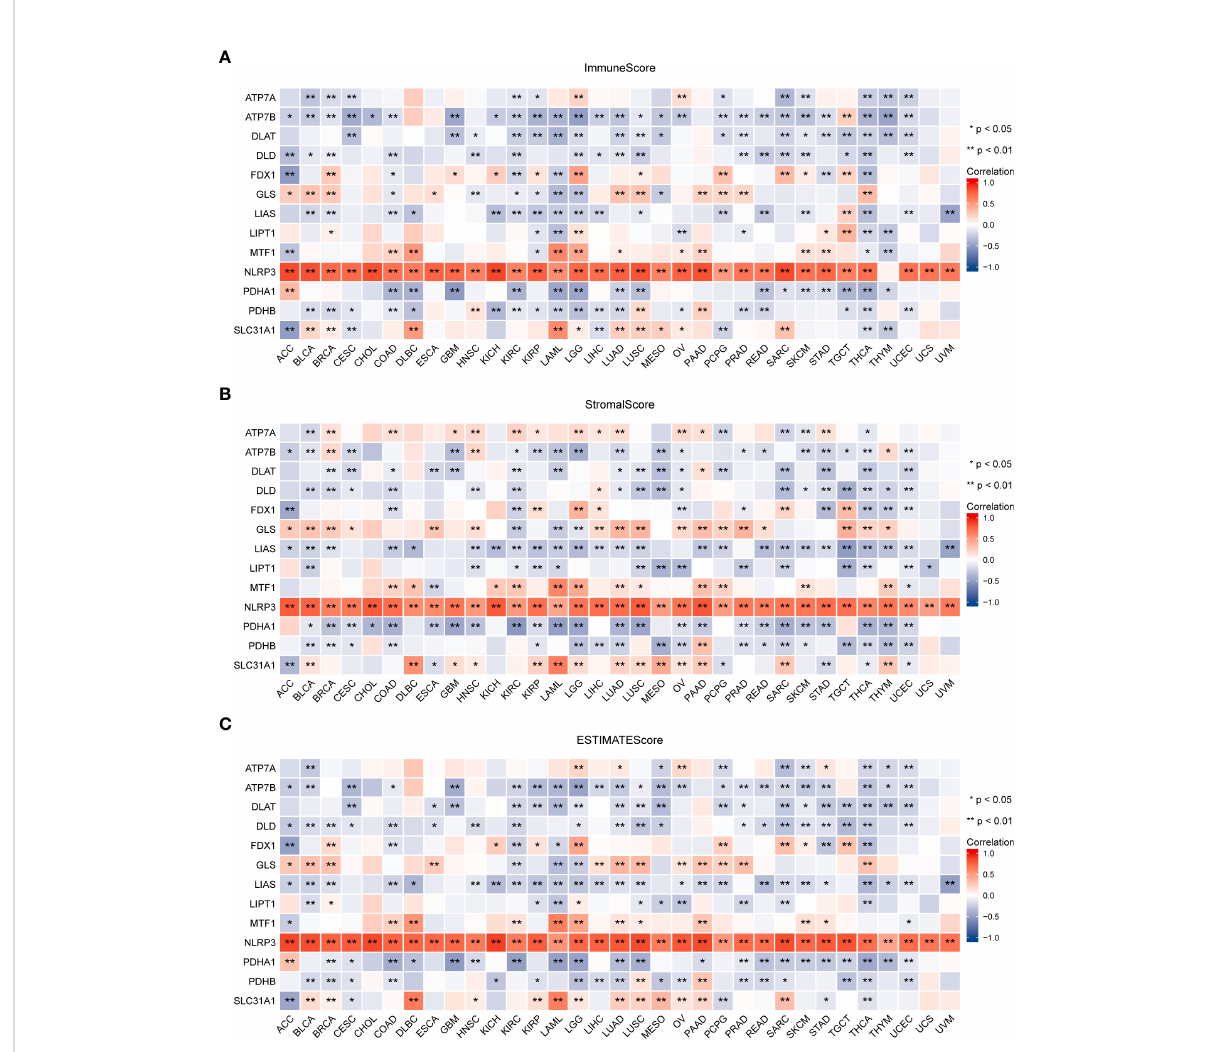
FIGURE 8 Association between the expression of cuproptosis-related genes and the tumor immune microenvironment in pan-cancer. Association between the expression of cuproptosis-related genes and immune scores (A) , stromal scores (B) , and ESTIMATE scores (C) (*P < 0.05; **P < 0.01). ESTIMATE, Estimation of Stromal and Immune cells in Malignant Tumor tissues using Expression